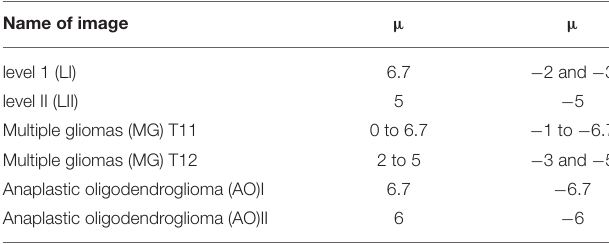
TABLE 4 | Image of group 2 of the best value of µ was from − 6.7 to